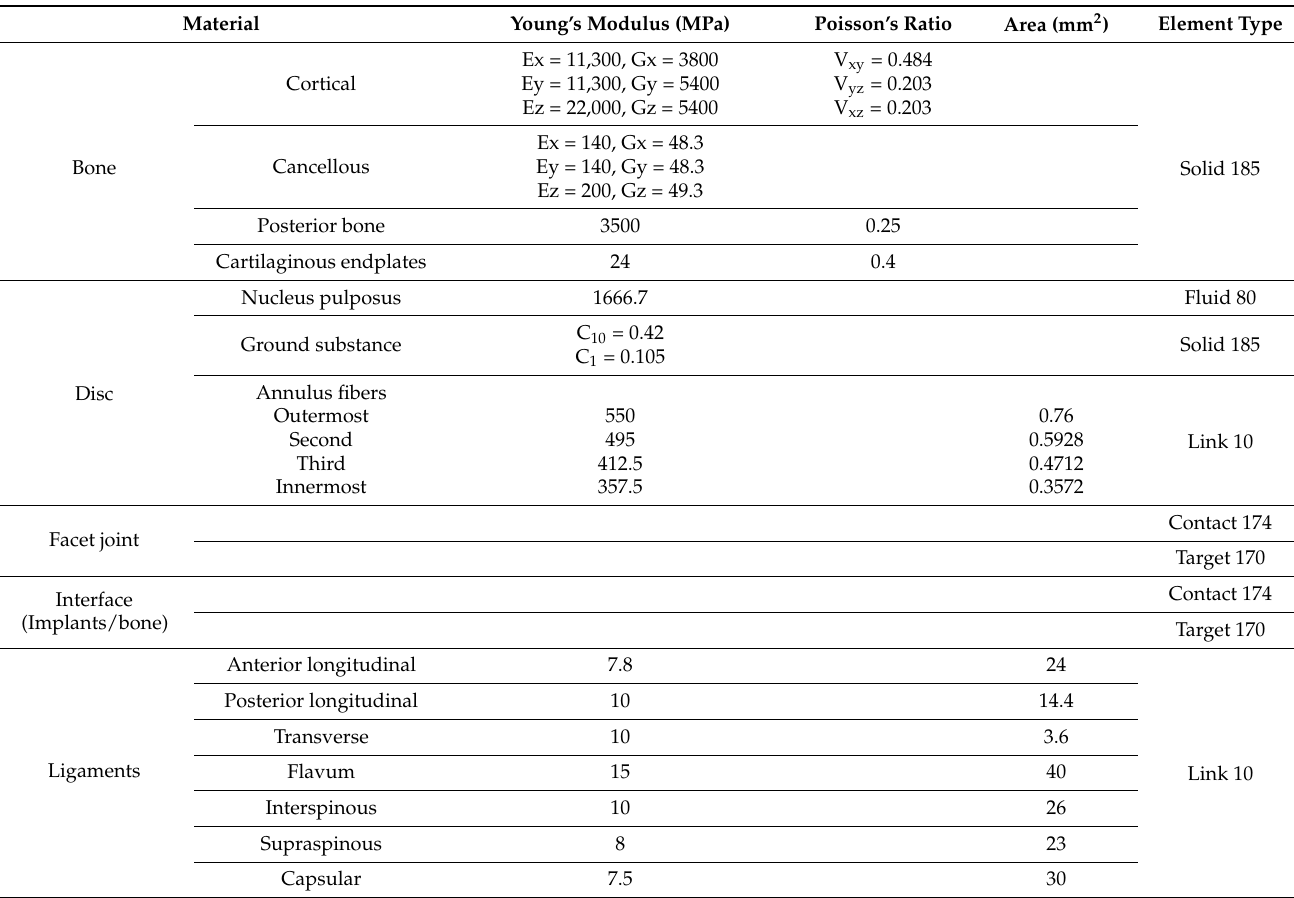
Table 1. Material properties used in the finite element